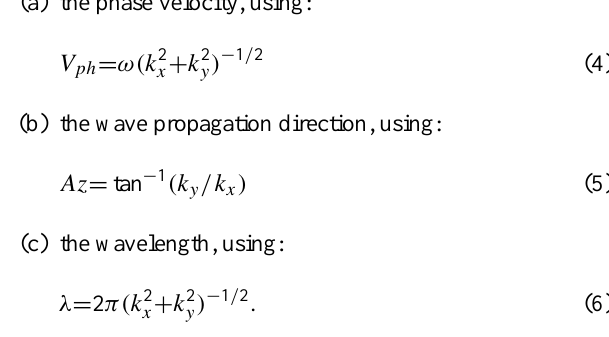
Fig. 4. Range-time-intensity plot of sea scatter power recorded from 00:00 UT to 04:00 UT on 30 June 2000 using TIGER beam 4. The time series of echo power were band-pass filtered over the period range 10 to 100min. An HF propagation factor, r =0.5, was applied to the range.